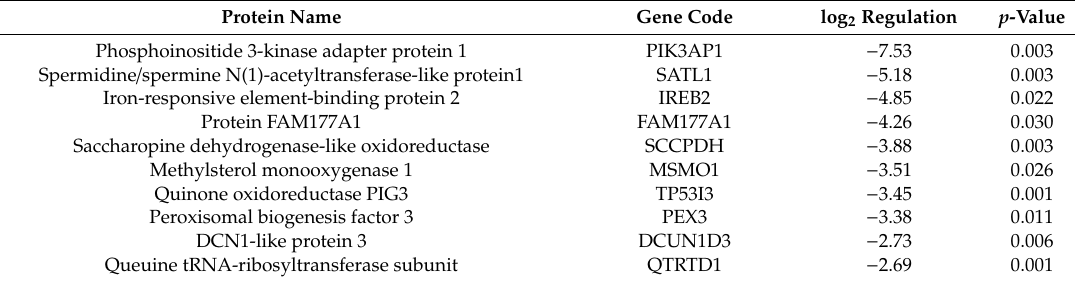
Table 5. Strongest downregulated proteins after EPX